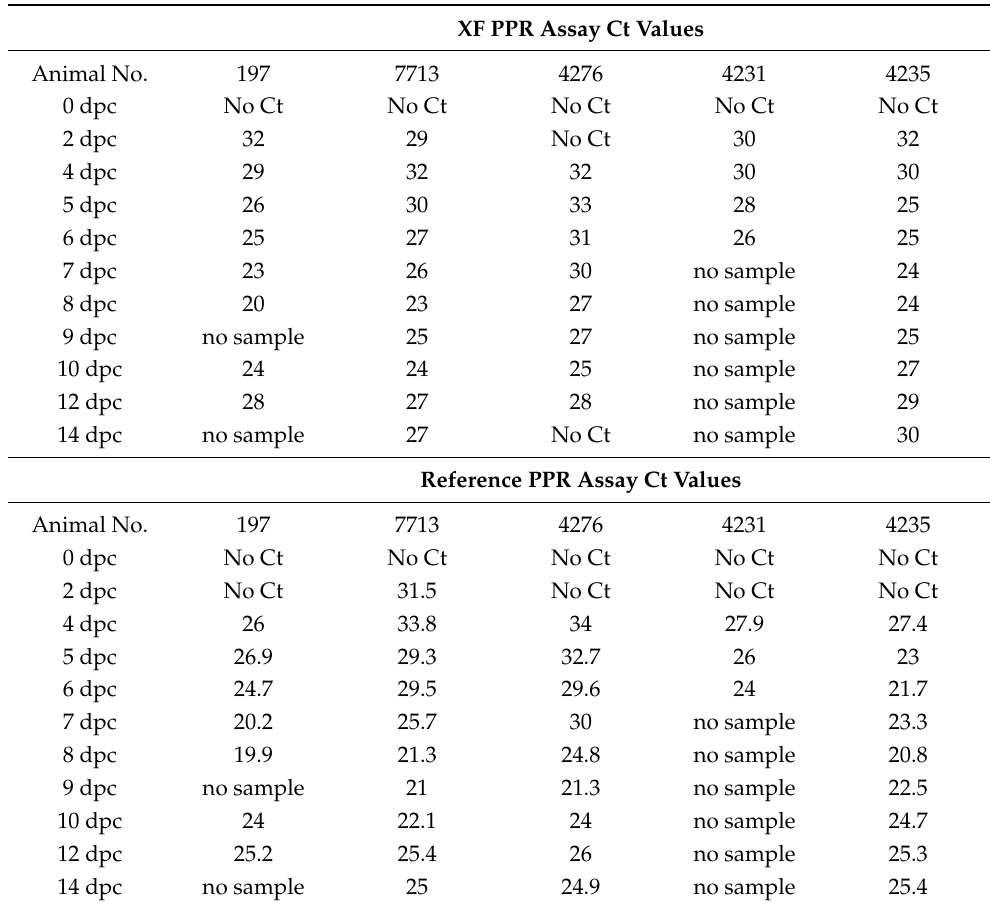
Table 4. Ct values that were obtained from the time course experiment for the five infected animals from 0 dpc to 14 dpc for the XF PPR assay and the reference assay. No Ct indicates that no amplification occurred for some of the time points.